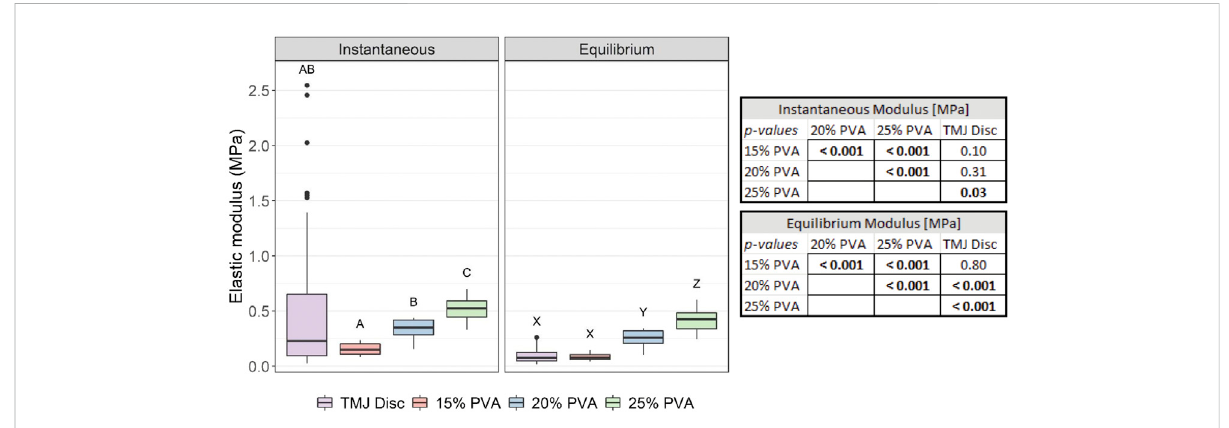
Box-and-whisker plots of the calculated instantaneous and equilibrium elastic moduli from indentation of the PVA hydrogels, and the pooled TMJ data from Labus et al [29]. Groups that do not share a letter were signi fi cantly different. All p -values for post hoc Wilcoxon rank-sum comparisons are provided in the associated table